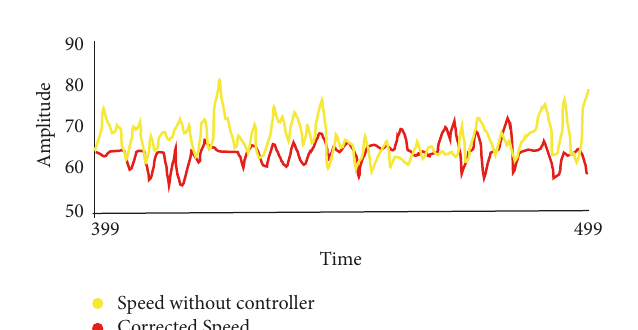
Figure 10: EV speeds for a minitrip.